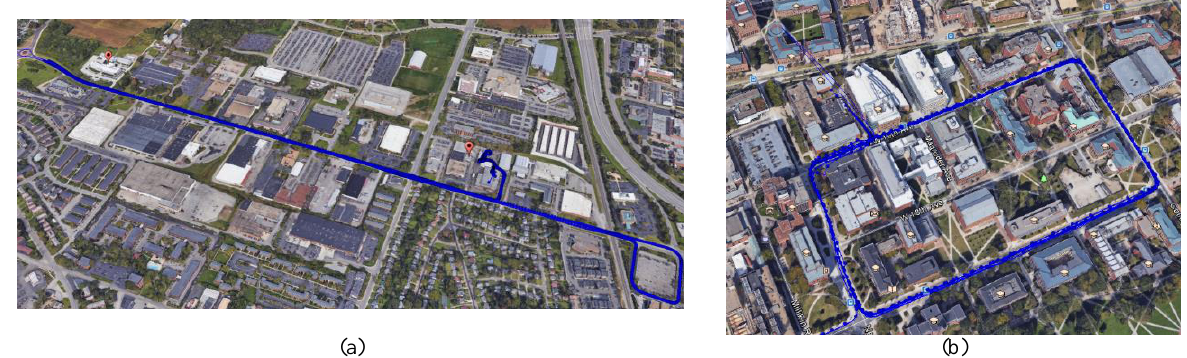
Figure 8. GPS/IMU trajectory solutions for the two test routes: (a) west campus, and (b) main campus loop.